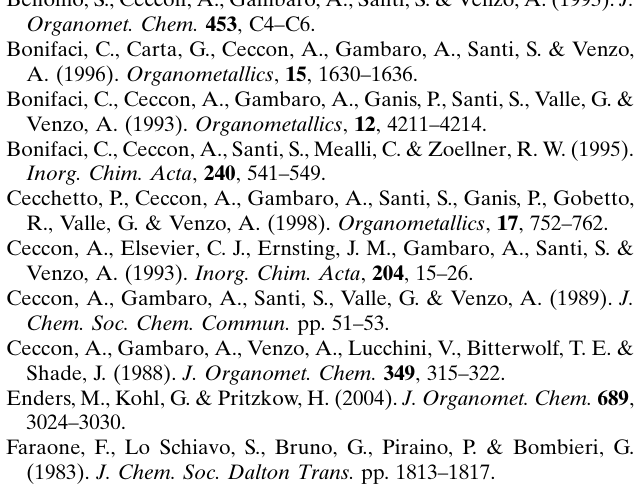
of pentane into a dichloromethane solution of 3 placed in a 5 mm-wide glass tube at ca 20 (cid:5) C to afford dark-red crystals (0.167 g, 0.20 mmol, 27%). Elemental analysis calculated for C H Cr O Rh : C, 42.46; H, 2.21. Found: C, 42.16; H, 2.51. 29 18 2 9 2 HRMS-ESI ( m / z ): [ M +1H] + calculated for C